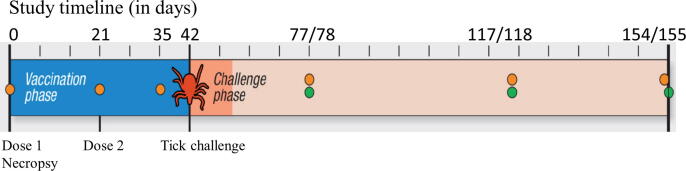
Schematic representation of study procedures and timeline. The schematic presented above indicates the timeline for significant procedures conducted in this study. The labels “dose 1” and “dose 2” indicate the days on which placebo or VANGUARD®crLyme vaccine were delivered. Blood draws (Days 0, 21, 35, 77, 117 and 153) and tissue biopsy (Days 78, 118 and 154/155) events are indicated by orange and green circles, respectively. Necropsies were performed over two days (154/155) to obtain samples for histopathology. The study also included four sentinel dogs that were not exposed to placebo, vaccine, or infected ticks but were otherwise assessed as all other study dogs. (For interpretation of the references to colour in this figure legend, the reader is referred to the web version of this article.)